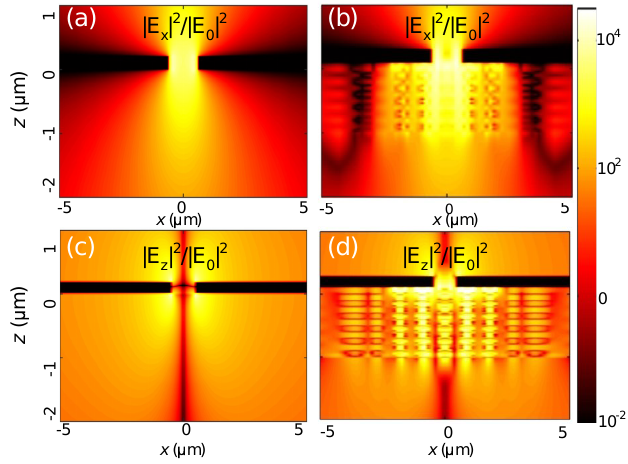
Figure 3. Local field enhancement contributed from electric field components E x and E z in side view at y = 0. The gold antenna ( a , c ) directly sits on the PI substrate, or ( b , d ) sits on the PI substrate buffered by the HMM with hole array.